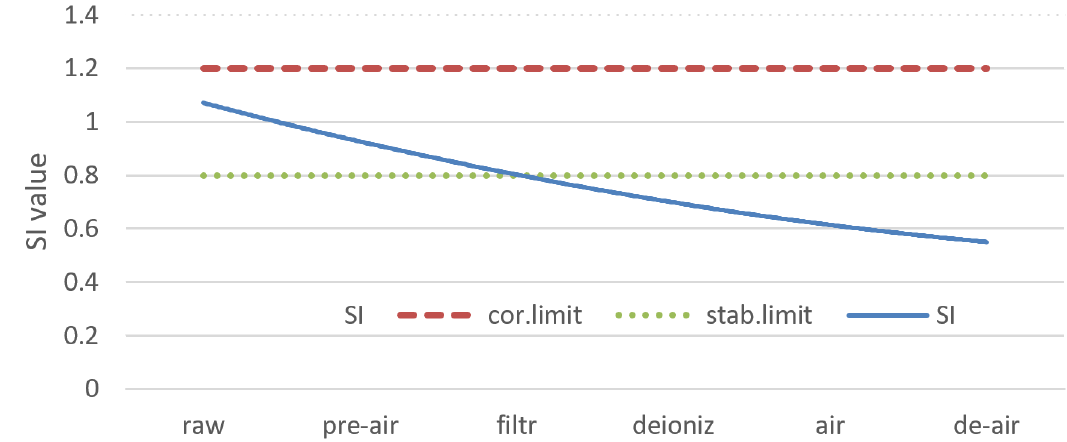
Figure 1. Changes of Singley Index (SI). Source: Own elaboration.